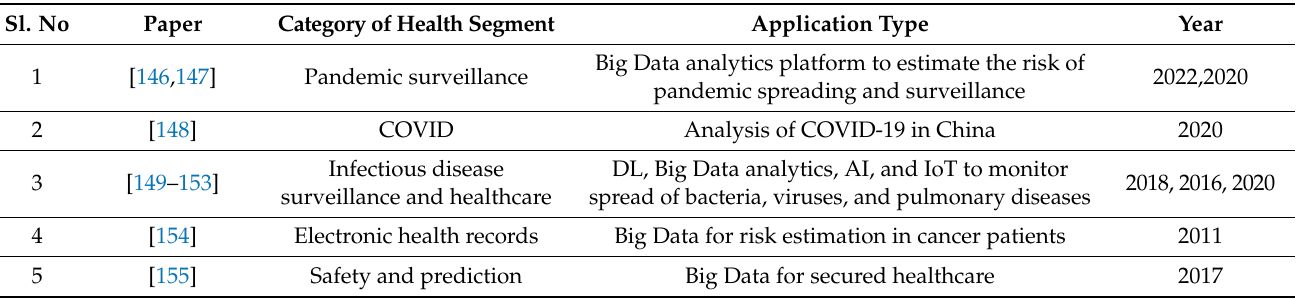
Table 3. Review of Big data in Healthcare.